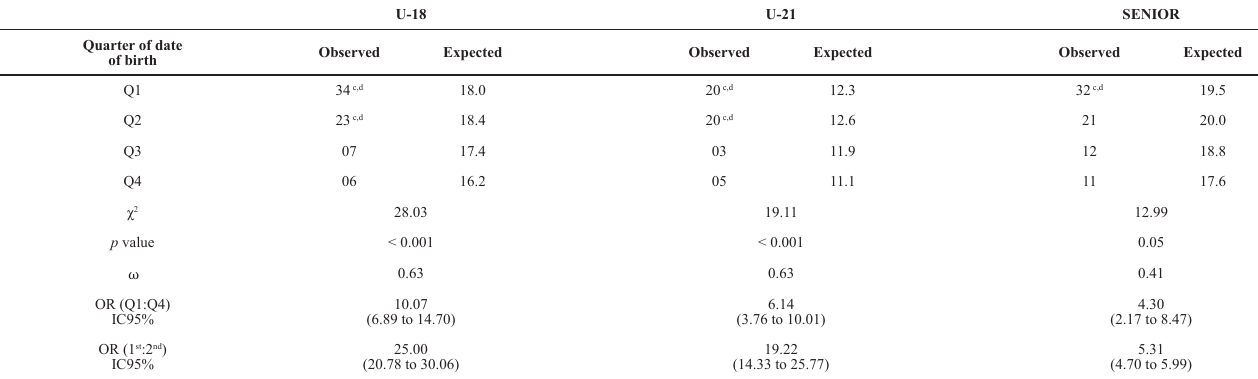
Table 1 - Absolute distribution of dates of birth as a function of the tournament category for male handball